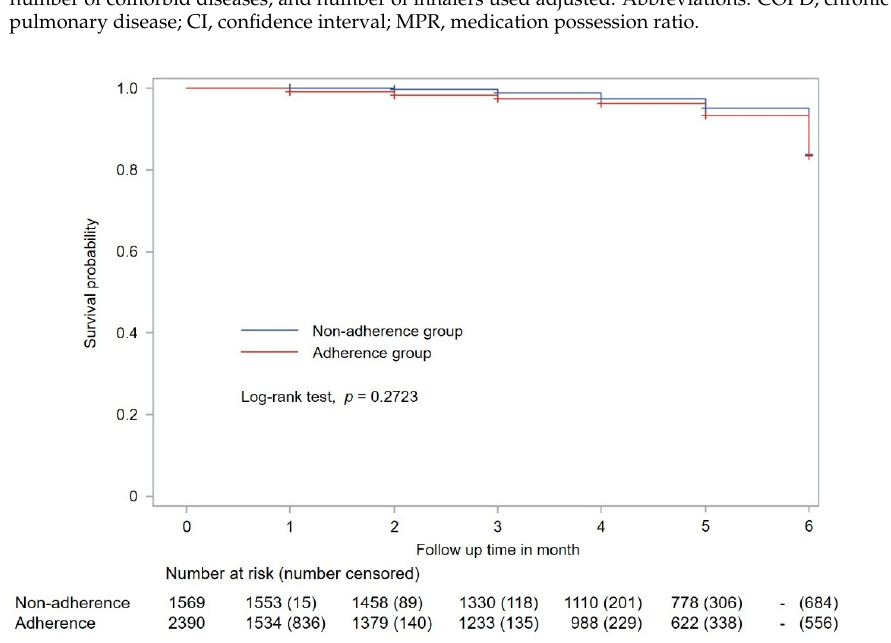
Figure 2. Kaplan–Meier plot showing acute exacerbation occurrence in patients with COPD. The adherence and non ‐ adherence groups are classified based on medication adherence to long ‐ acting inhalers. COPD, chronic obstructive pulmonary